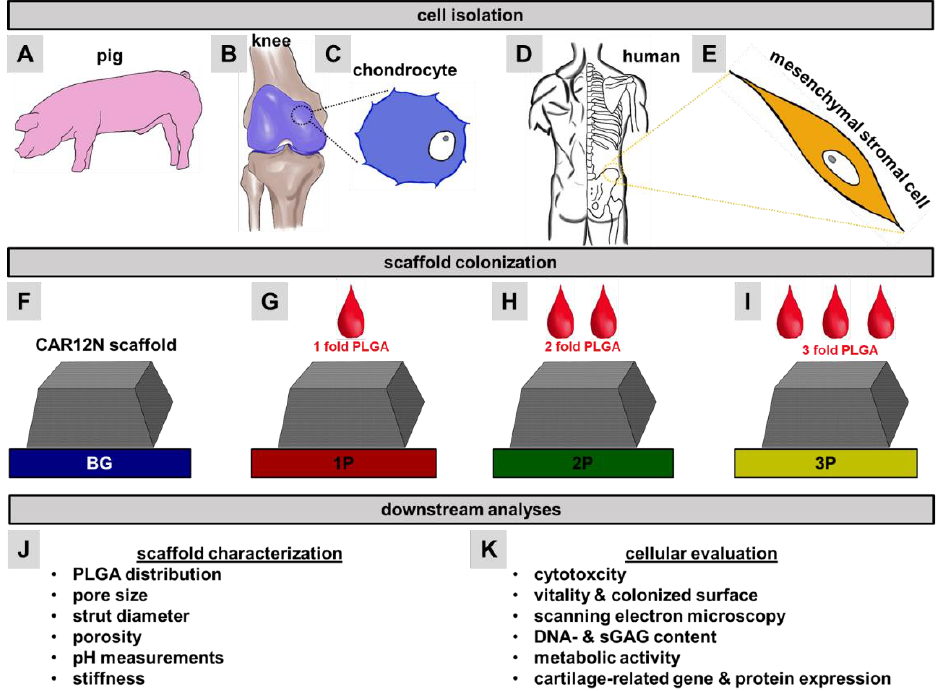
Figure 1. Graphical abstract. Knee joints from the pig ( A , B ) were explanted in order to isolate native chondrocytes ( C ). From the human iliac crest ( D ) mesenchymal stem cells ( E ) were obtained. Primary cells were subsequently colonized on pure bioactive glass scaffolds (BG, F ), which were one-time (1P, G ), twice (2P, H ), or three times (3P, I ) infiltrated with Poly(D-L-lactide-co-glycolide) (PLGA). Prior to colonization extensive analyses were performed to characterize the material properties ( J ). After up to 35 days in a dynamic culture, the cellular changes (cytotoxicity, viability, colonized surface, scanning electron microscopy, DNA and sulfated glycosaminoglycan (sGAG) contents, metabolic activity, immunocytochemical staining and real time polymerase chain reactions (PCR)) were examined in more detail ( K ).